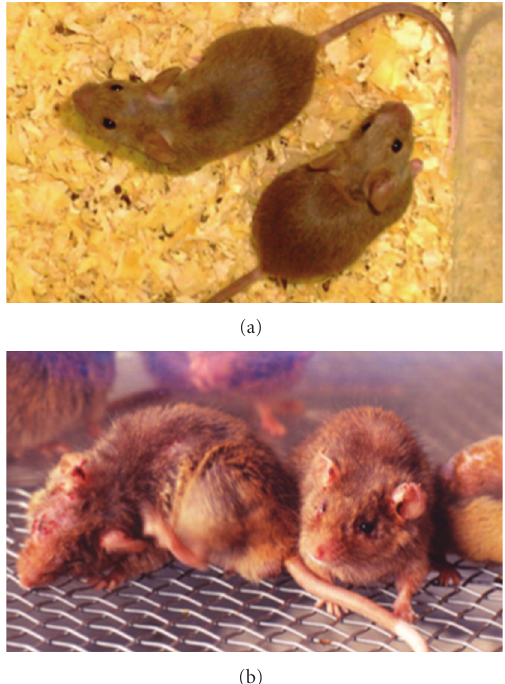
Figure 1: NC/NgaTnd mice maintained in air-regulated SPF (a) or air-unregulated conventional circumstances (b).